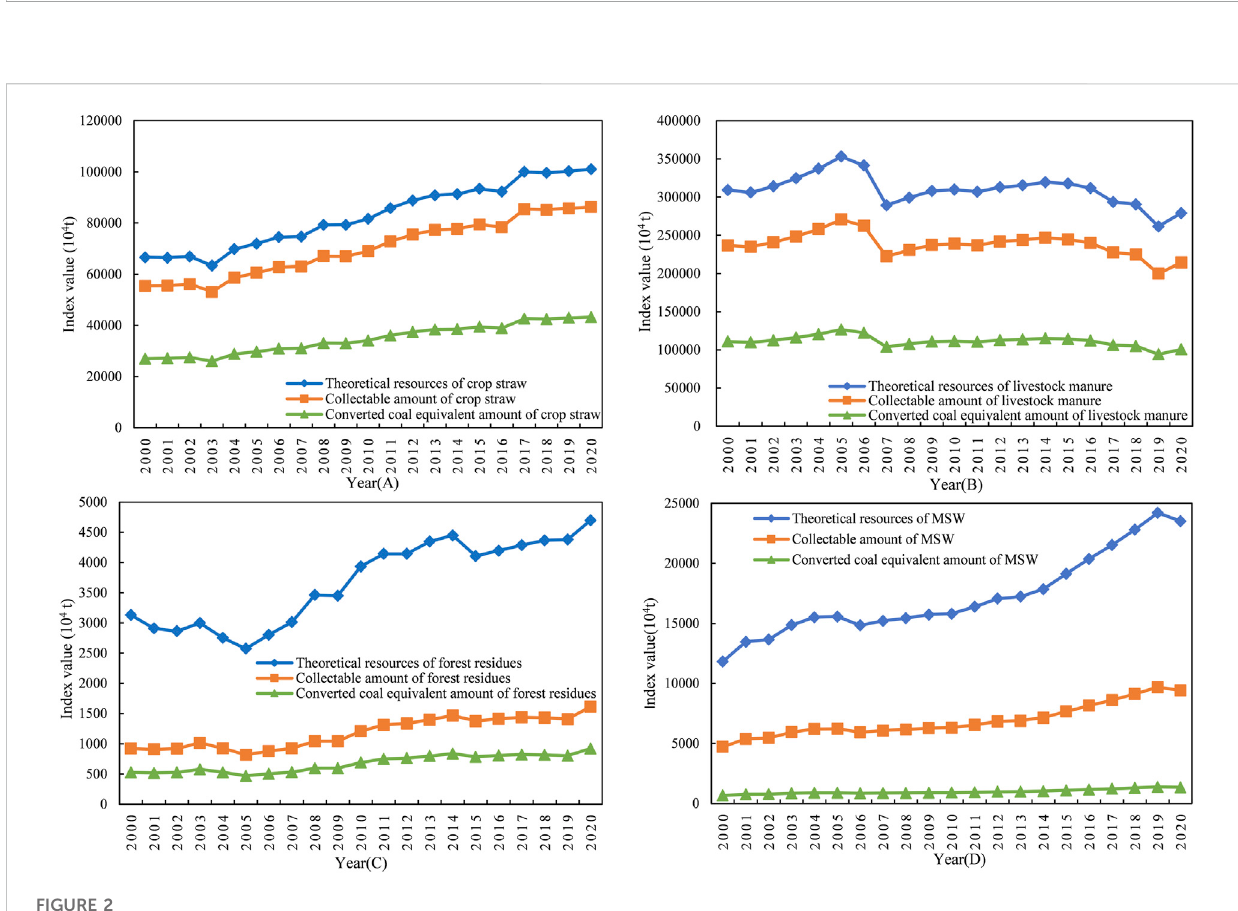
FIGURE 2 Changes of various biomass energy indicators in China from 2000 to 2020 (A – D)